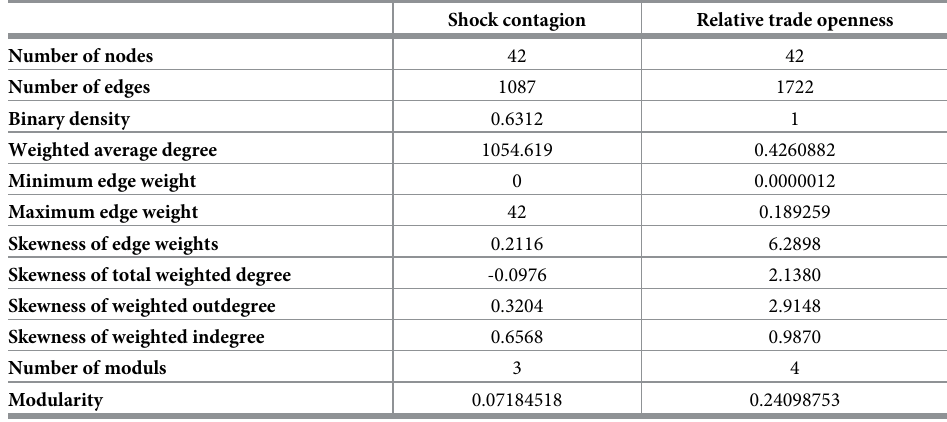
Table 4. Global network indicators of the shock contagion and the relative trade openness